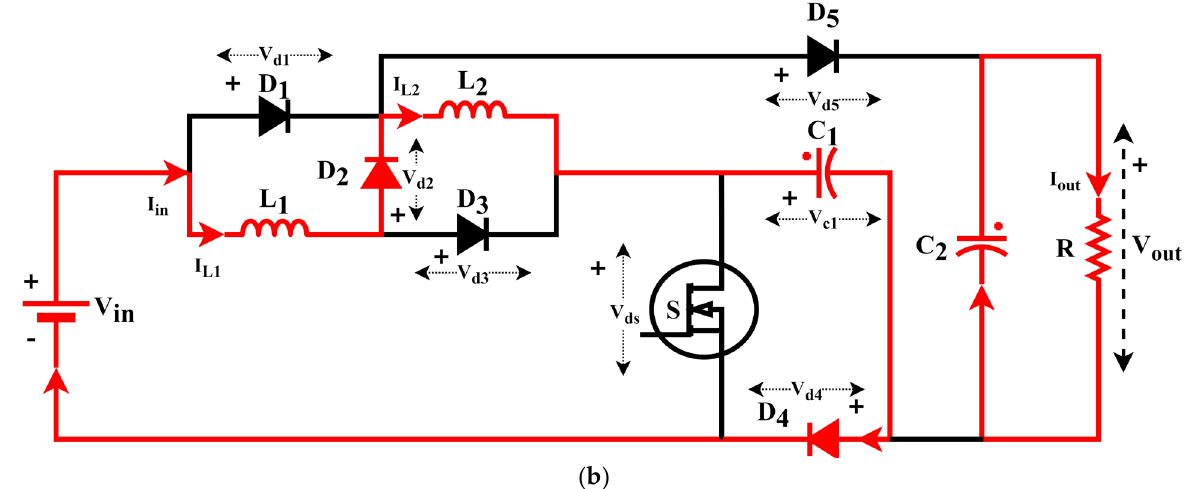
Figure 4. Operating modes of the MQZS; ( a ) Mode − a; ( b ) Mode − b. Mode-b (t 1 − t 2 ): When the S is switched off, mode-b starts at t = t 1 . The current path